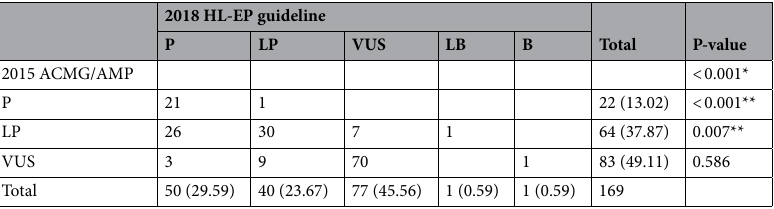
Table 1. Comparisons of variant classifications between 2018 Expert Panel classifications and 2015 ACMG/ AMP guideline. P pathogenic, LP likely pathogenic, VUS variant of uncertain significance, LB likely benign, B benign. *P < 0.05, Chi-square test, 2015 ACMG/AMP vs. 2018 HL-EP guideline. **P < 0.05, Chi-square test, 2015 ACMG/AMP vs. 2018 HL-EP guideline for each